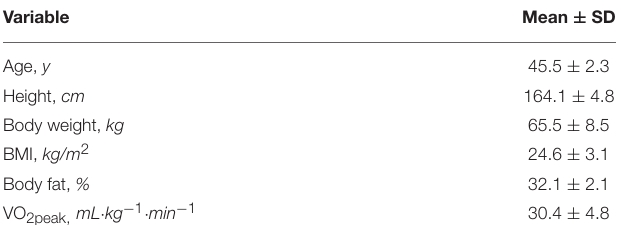
TABLE 1 | Baseline characteristics of participants ( N = 12).